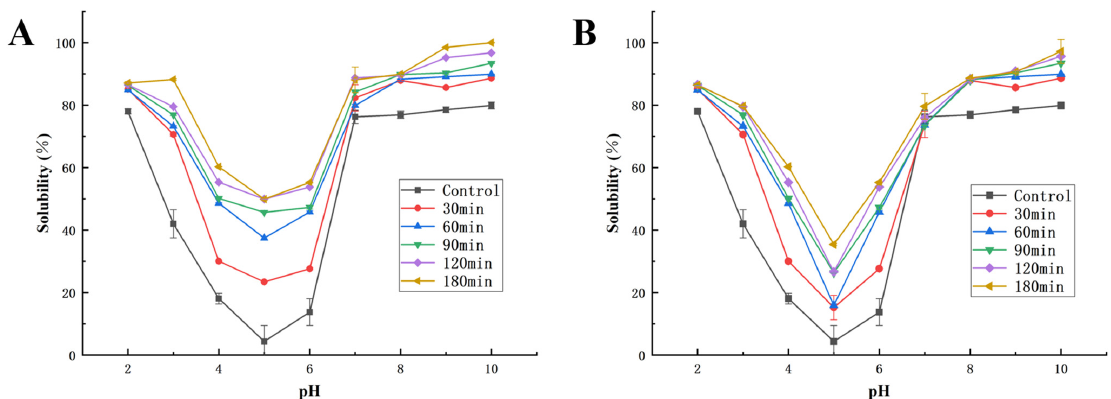
Figure 6. Solubility at different pH: ( A ) Solubility of ACHNs; ( B ) Solubility of